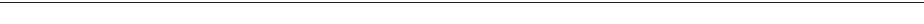
Fig. 4 Reproductive phenotype of homozygous and heterozygous Cfap43 and Cfap44 male mice. a Fertility of Cfap43 +/ − , Cfap44 +/ − Cfap43 − / − , and Cfap44 − / − males. Heterozygous and homozygous mutant males were mated with WT females and the numbers of pups per litter were measured. KO males were completely sterile. b , c Spermatocytograms showing the number of abnormal sperm in heterozygous and homozygous mutant males. d – f Images of typical sperm stained with Harris – Shorr from Cfap43 − / − and Cfap44 − / − males. Scale bars = 10 µ m. g Total and progressive motilities of sperm from Cfap43 − / − and Cfap44 − / − males. h – m The mitochondria sheath is fragmented in Cfap44 − / − males. Staining of WT sperm with an anti-MCPl1 ( h , green), a mitochondrial transporter, and anti-acetylated tubulin ( i , red) antibodies. j Overlay of MCPl1 and tubulin staining. Sperms were counterstained with Hoechst (blue). k – m Similar experiments on sperm from Cfap44 − / − males. Scale bars = 10 µ m. a – c , g Data represent mean ± SD; statistical differences were assessed with t test, P value as